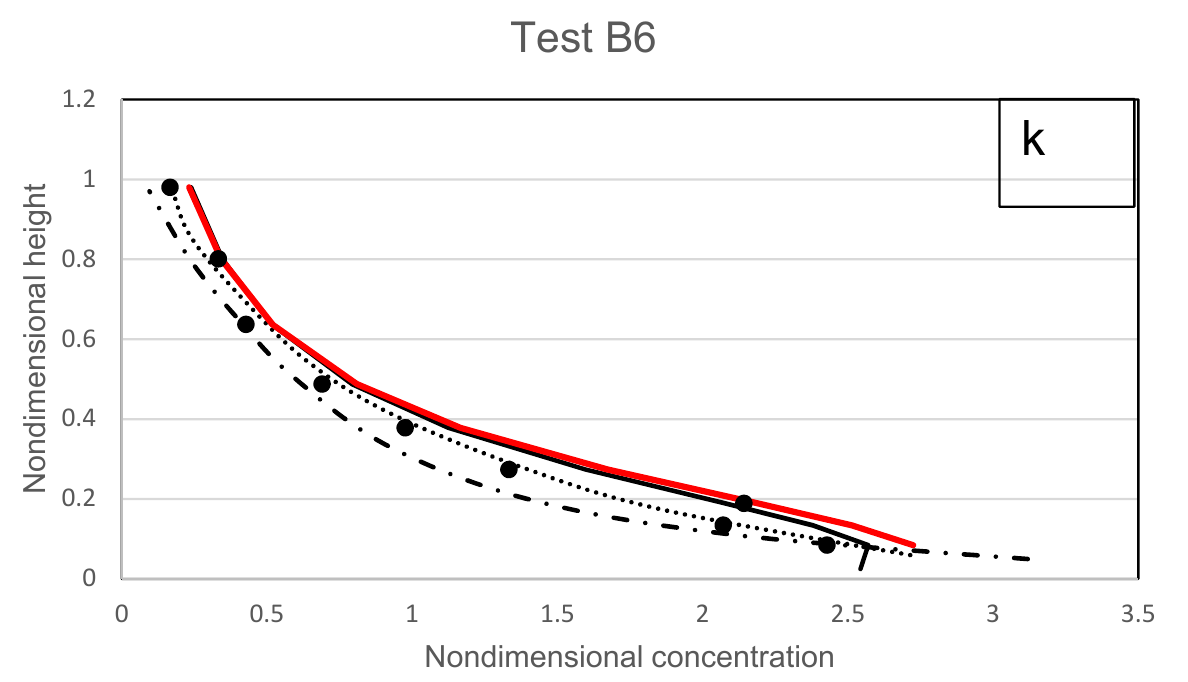
Figure 17. ( a – k ) The modelled results and comparisons against experimental data of Wang and Ni [31] and models of Wang and Ni [21], Pu et al. [1], Ni et al. [10] and Zhong et al. [23].